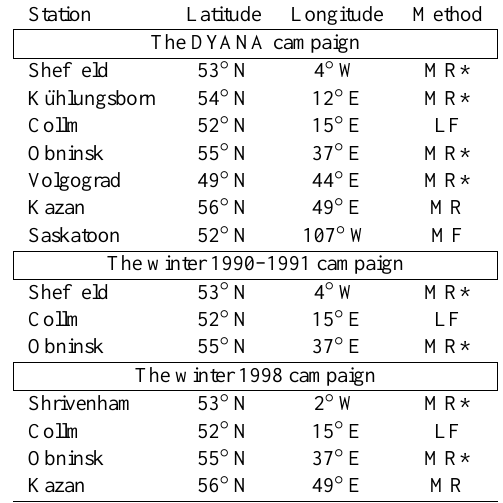
Table 1. Mesosphere/lower thermosphere wind measuring stations considered during the 3 campaigns. The measurements are carried out by meteor radar (MR), low-frequency drift measurements (LF) and medium frequency radar (MF). Measurements without height finding are marked by an